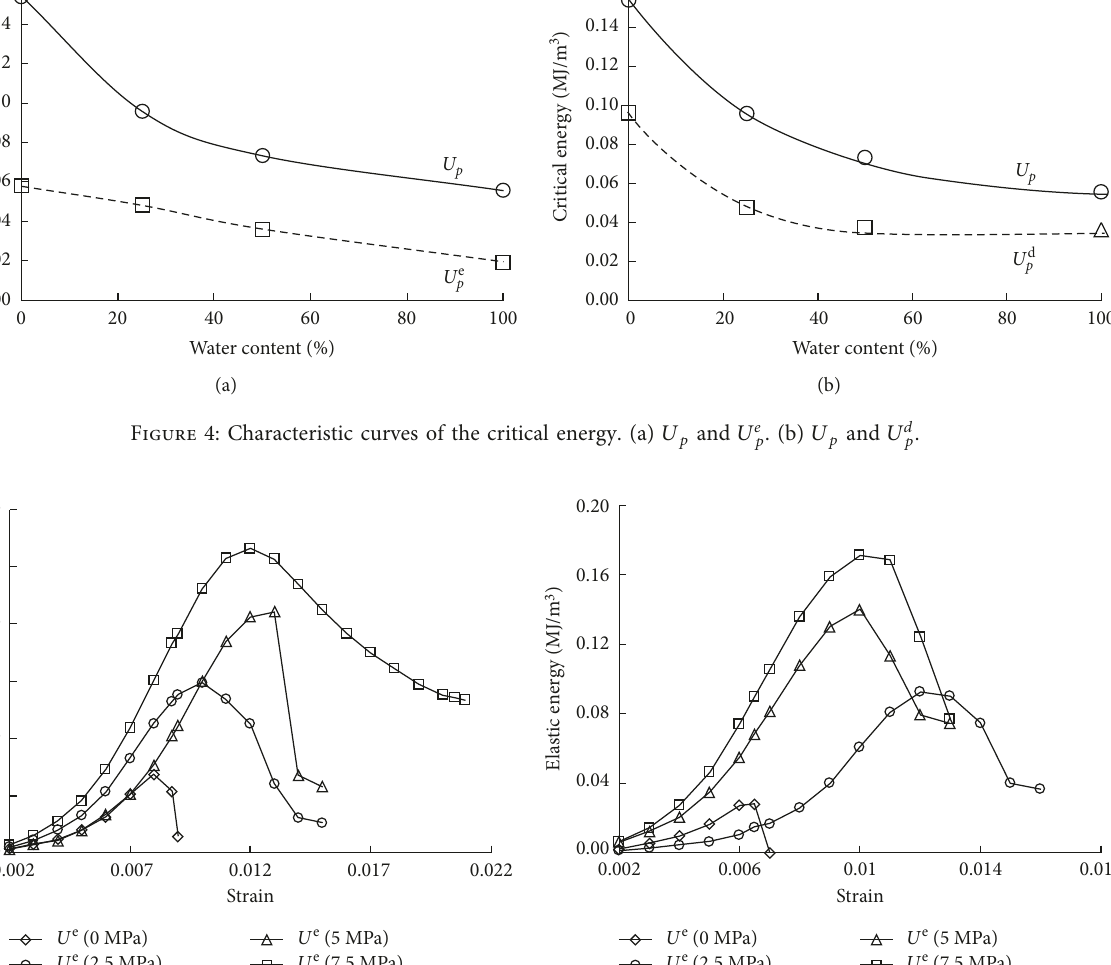
Figure 5: Energy evolution curves with different water contents: (a) 0% and (b)